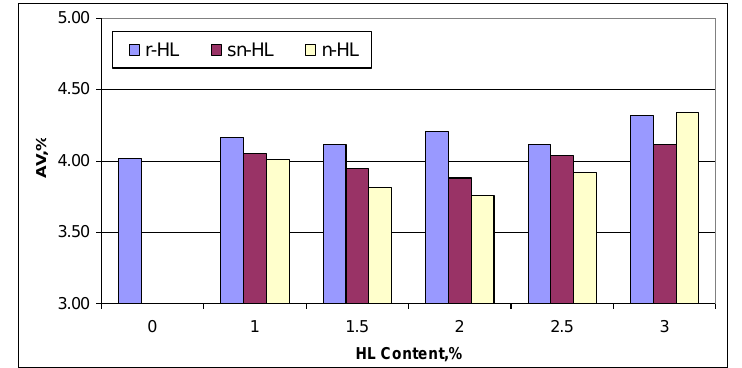
Figure 10. Comparison of air voids.